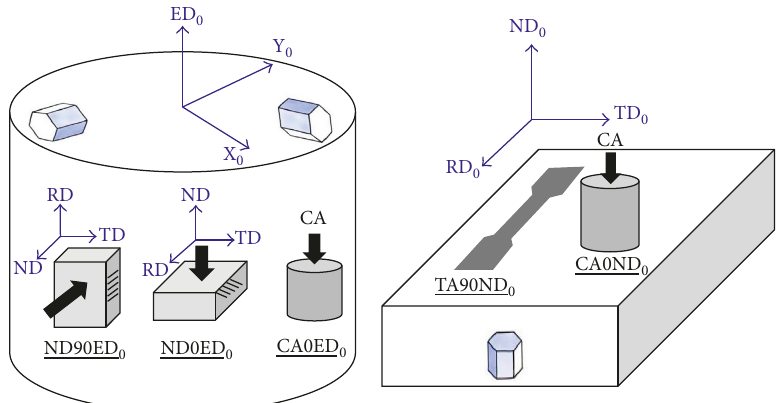
Figure 1: Schematic illustration of the orientations of the samples machined from the cylindrical extruded bar and rolled plate and used in plane strain compression (ND90ED 0 and ND0ED 0 ), simple compression (CA0ED 0 and CA0ND 0 ), and uniaxial tensile (TA90ND 0 ) tests. The typical crystallographic orientations of the c -axis resulting from extrusion and rolling processes are also shown.